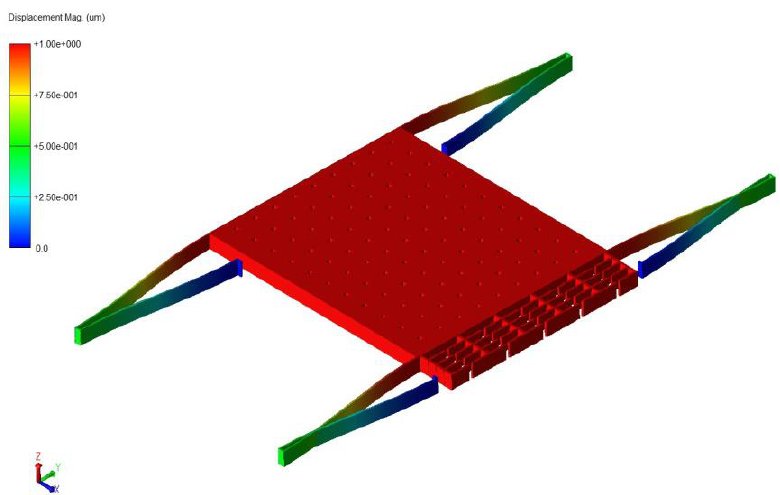
Figure 8. Finite element simulation of detection structure (single-stage beam).